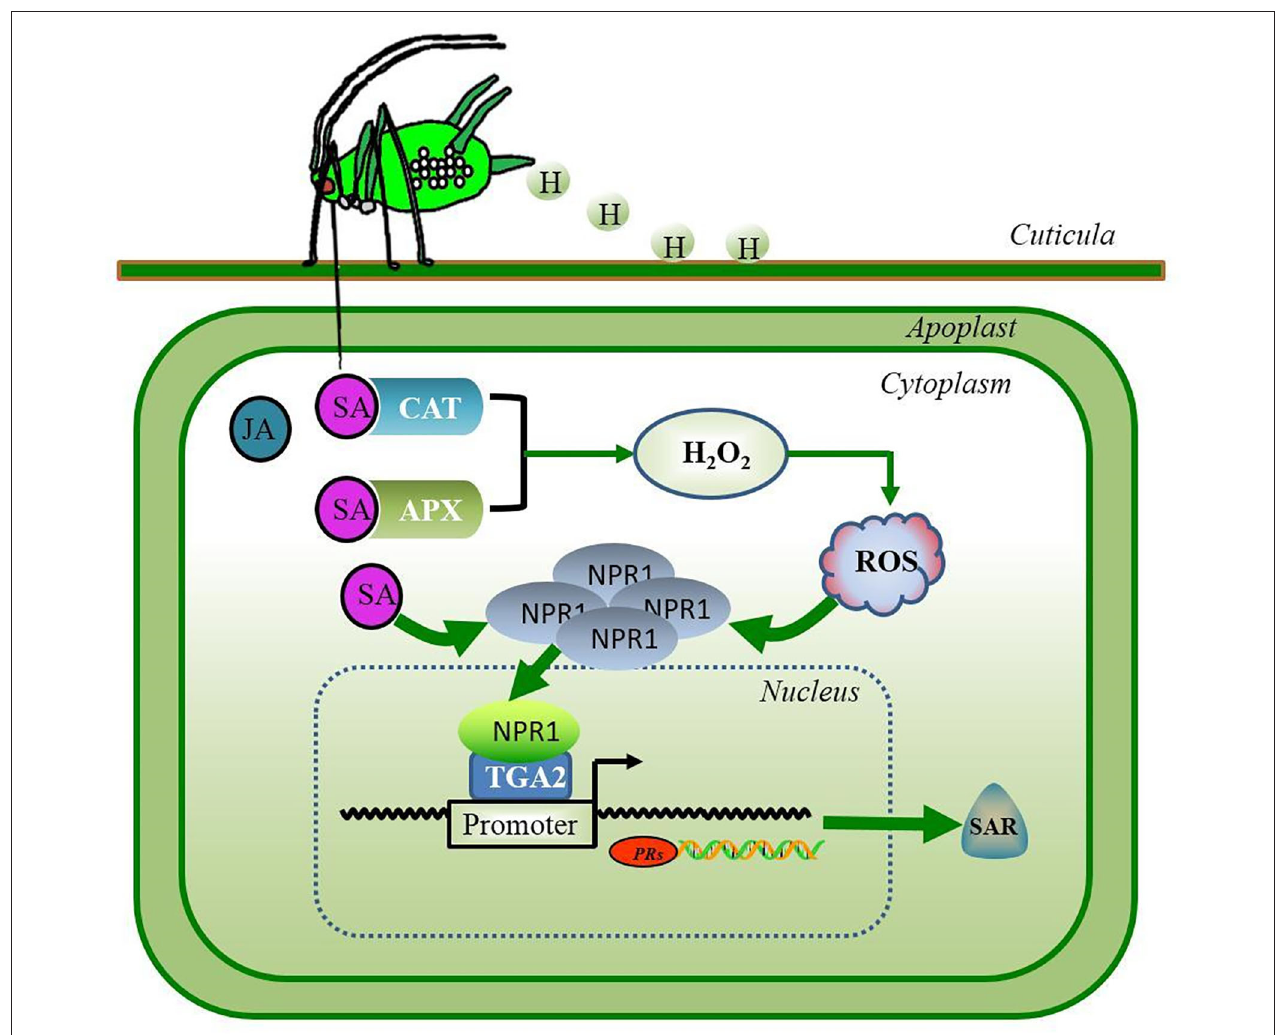
FIGURE 1 | The feeding behavior of the piercing-sucking herbivore S. avenae induces hormone-mediated defense signaling in wheat. Salicylic acid (SA) is the primary phytohormone in plant defense against the aphid insects. The SA-binding proteins APX and CAT rapidly bind SA, resulting in the extensive accumulation of H 2 O 2 . Extra H 2 O 2 rapidly disrupts ROS homeostasis that may induce the dissociation of oligomeric NPR1 into a monomeric form. The translocation of monomeric NPR1 into the nucleus leads to association with the transcription factor TGA2 in an enhanceosome, thereby activating the expression of defense genes and triggering SAR in plants. Green lines and arrows indicate the pathways of SA signaling. APX, ascorbate peroxidase; CAT, catalase; H, aphid honeydew; H 2 O 2 , hydrogen peroxide; JA, jasmonic acid; NPR1, non-expressor of pathogenicity-related genes 1; PRs, pathogenicity-related proteins; ROS, reactive oxygen species; SAR, systemic acquired resistance; TGA2, transcript factor TGACG binding